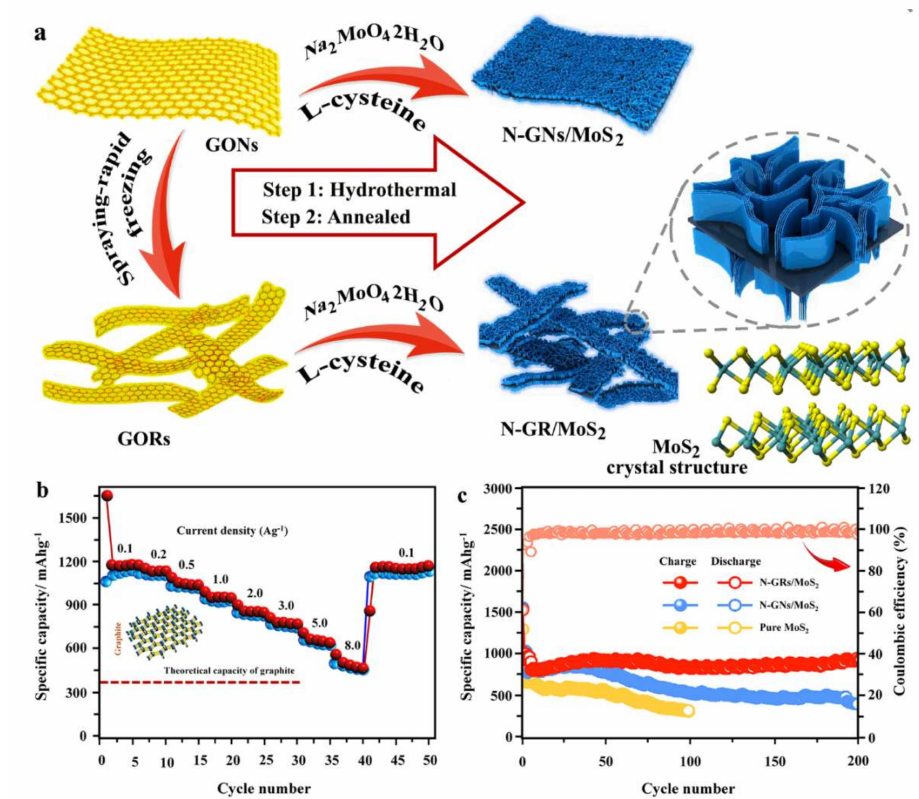
Figure 12. Nitrogen-doped graphene nanoribbons and nanosheets composite with MoS 2 ; ( a ) schematic illustration on the preparation of N-doped graphene ribbons/molybdenum sulfide (N-GRs/MoS 2 ) and N-doped graphene nanosheets/molybdenum sulfide (N-GNs/MoS 2 ) composites, ( b ) cycle stability of N-GRs/MoS 2 from 0.1 to 8.0 A g − 1 and ( c ) cycling performance comparison of N-GRs/MoS 2 , N-GNs/MoS 2, and pure MoS 2 at the current density of 0.5 A g − 1 . Adapted and reproduced with permission from Ref. [43]. Copyright 2021 Elsevier.